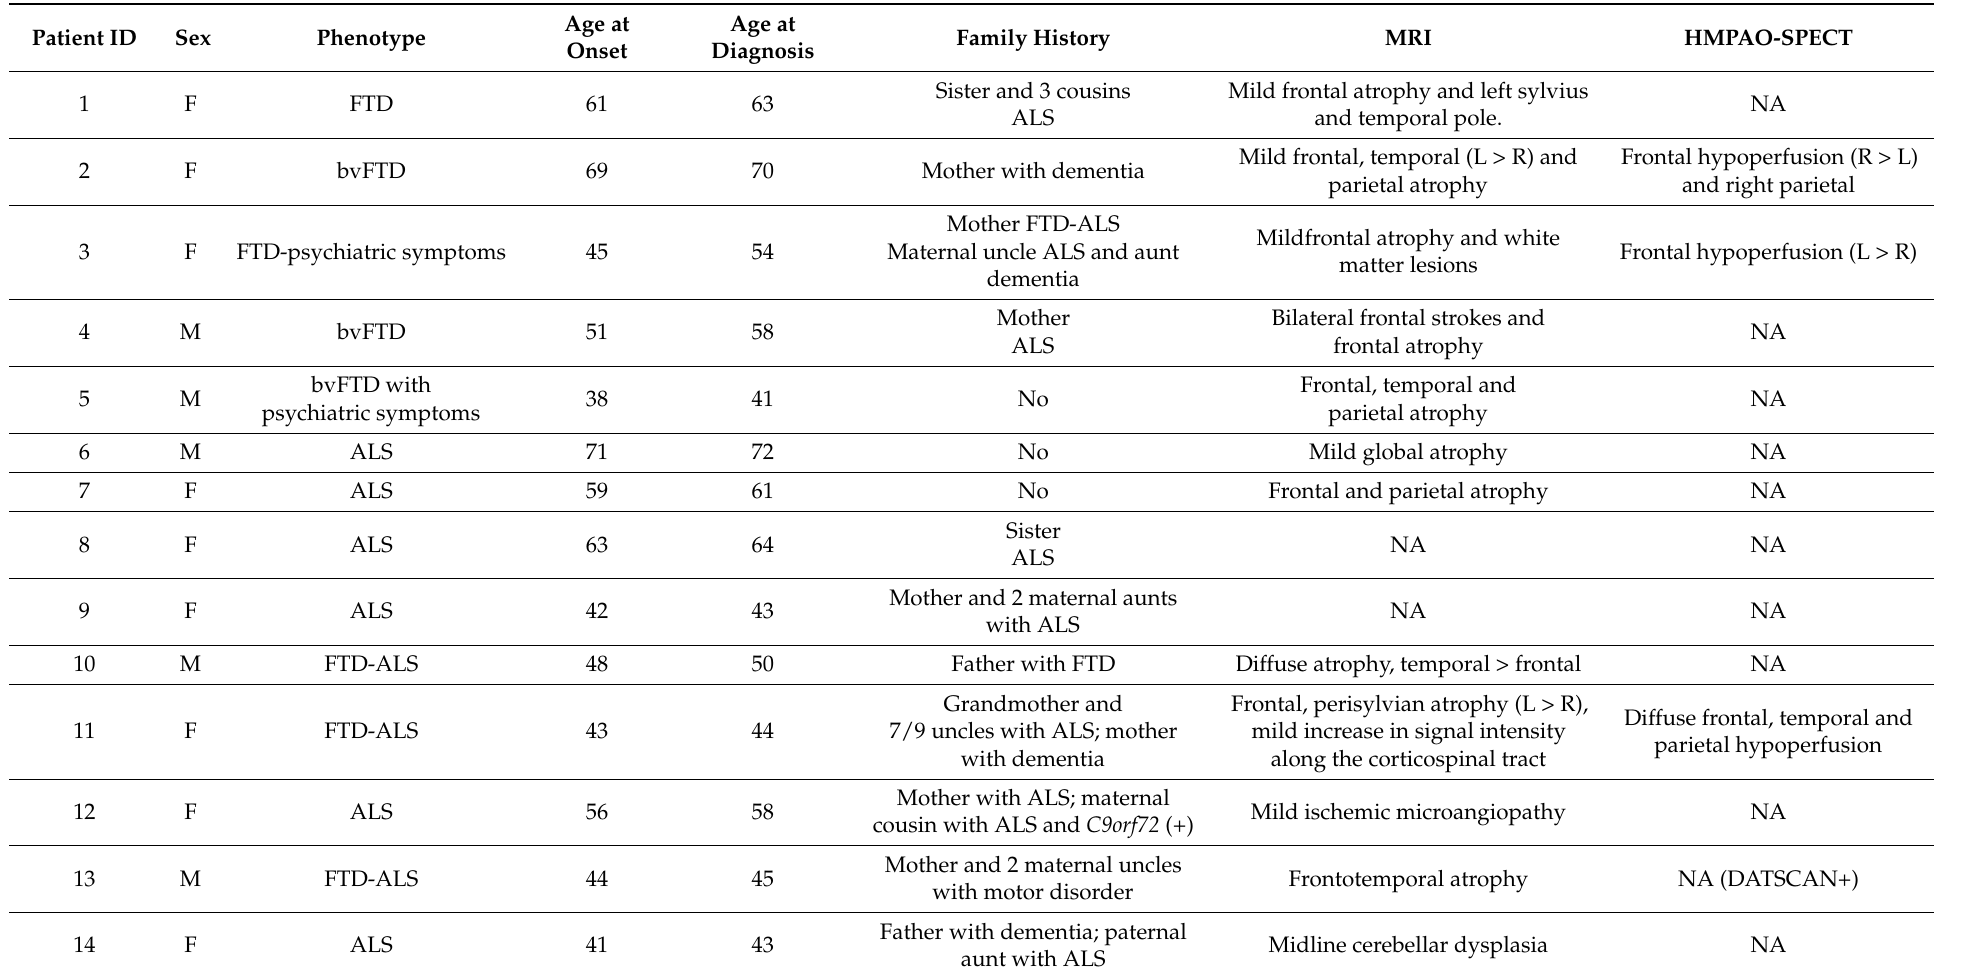
Table 2. Patients with C9orf72 hexanucleotide repeat